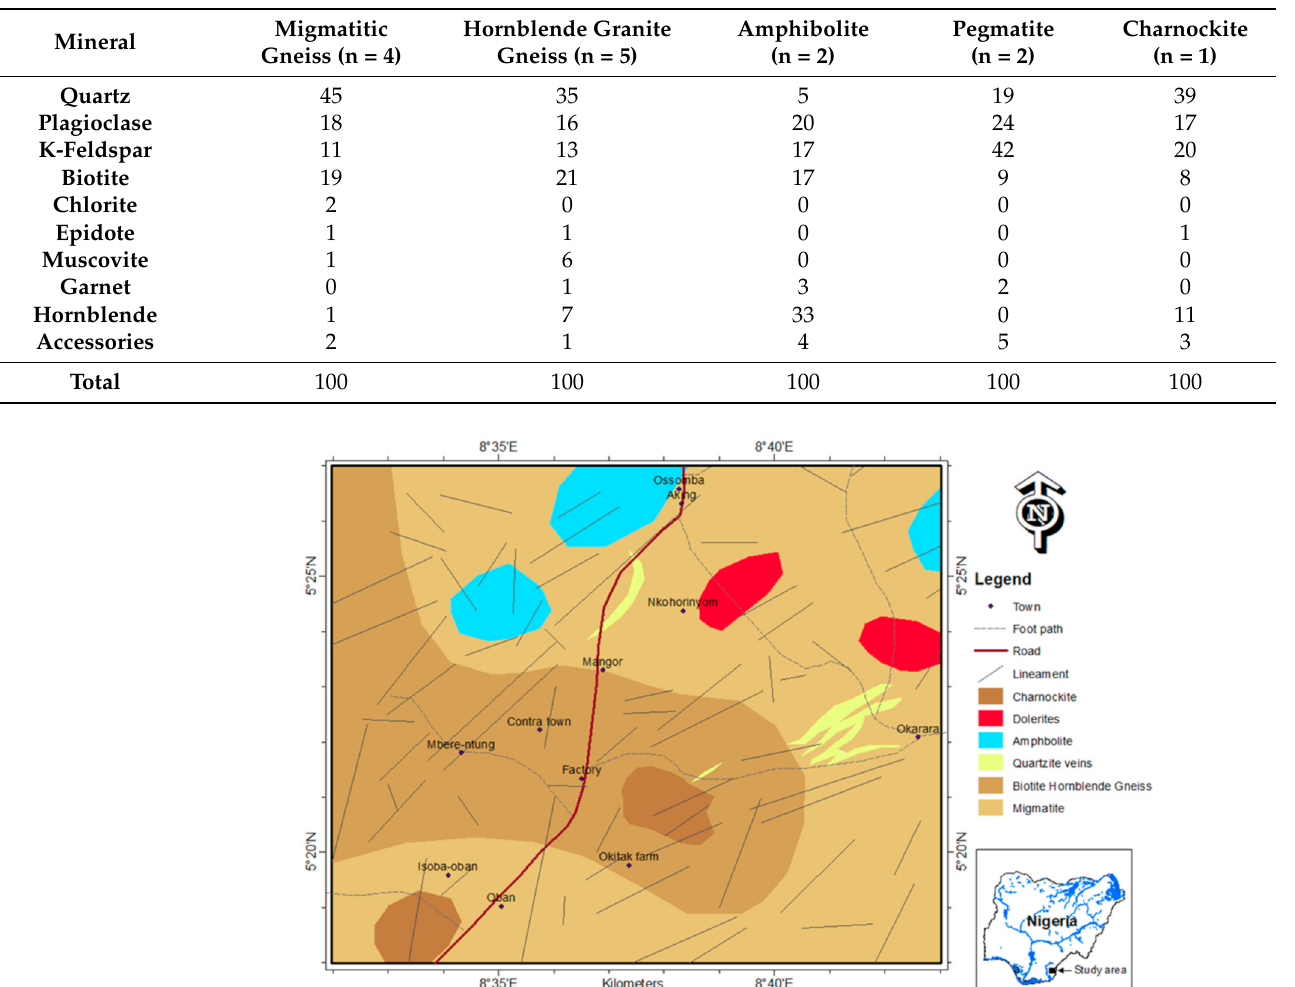
Table 1. Modal composition of rocks of the study area.